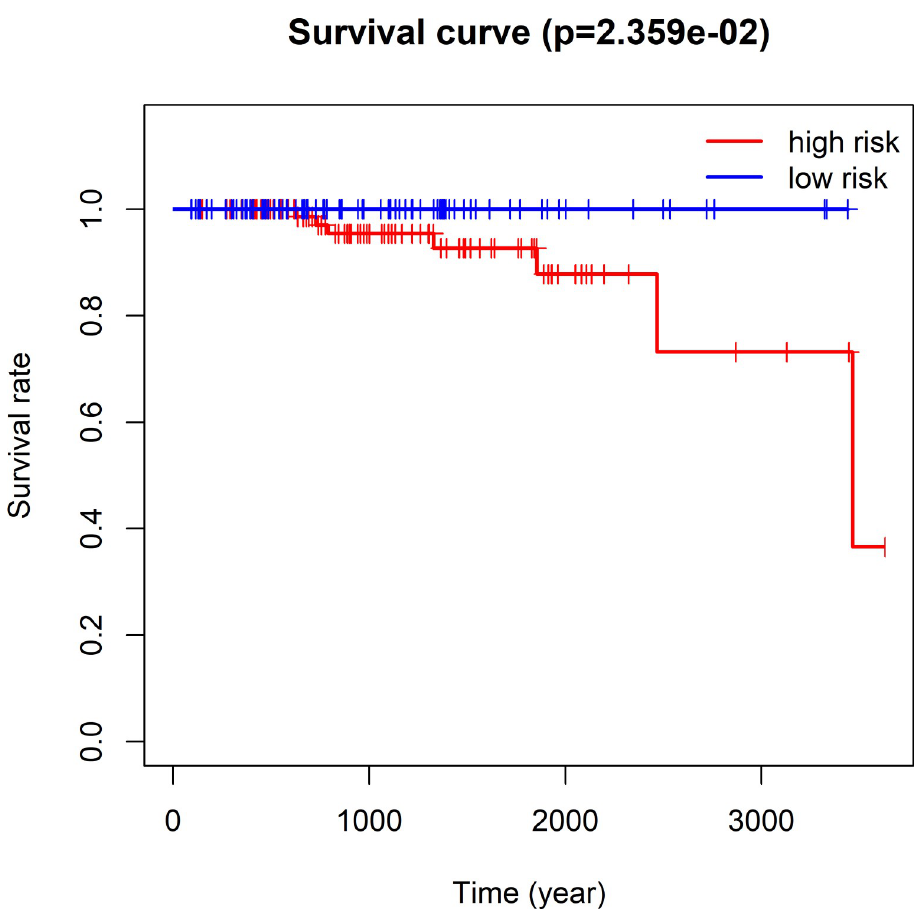
Fig 12. TCGA Kaplan-Meier survival analysis for PCa cases having the Gleason score > 7. All cases were classified as high- or low-risk group using the four-lncRNAs model.